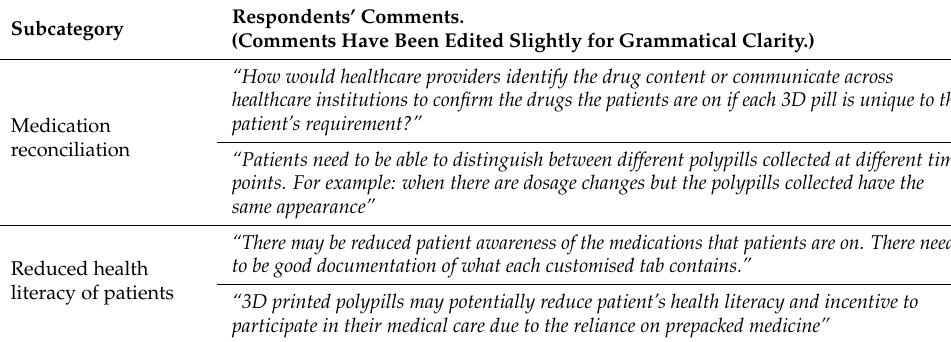
Table 2. Concerns raised by healthcare professionals in the administrative category. Respondents’ Comments. Subcategory (Comments Have Been Edited Slightly for Grammatical